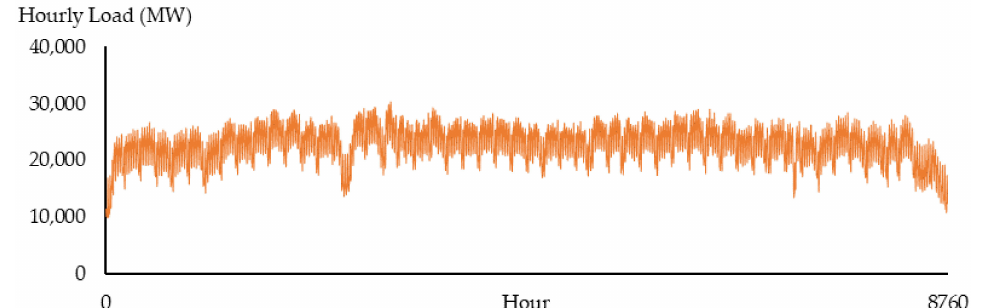
Figure 4. Full-year hourly load curve of 2017.